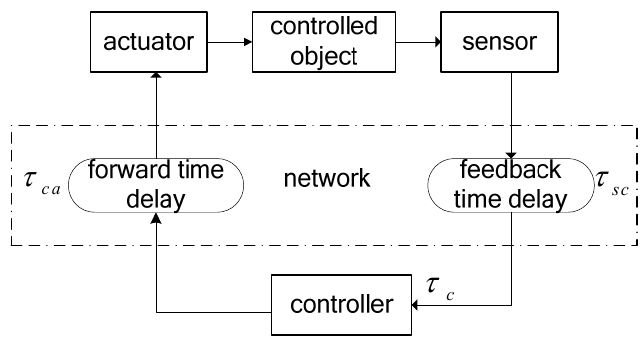
Figure 1. Networked control system with time delay.